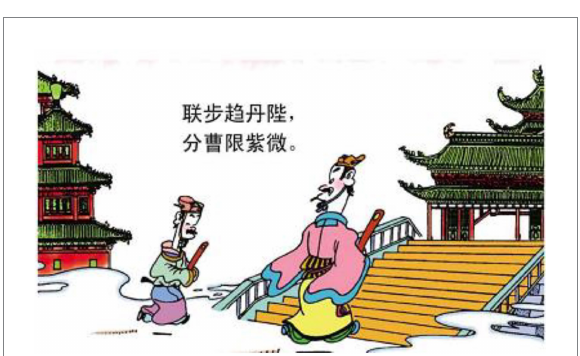
FIGURE 8 The second panel on Cai (2014, p. 68). Images reproduced with permission from Shang Dong People Press.